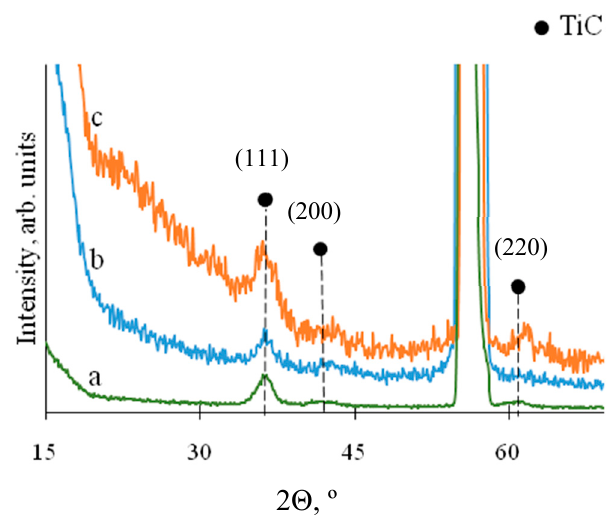
Figure 3. X-ray di ff raction (XRD) patterns of coatings produced in Ar ( a ), C 2 H 4 ( b ), and N 2 ( c ).